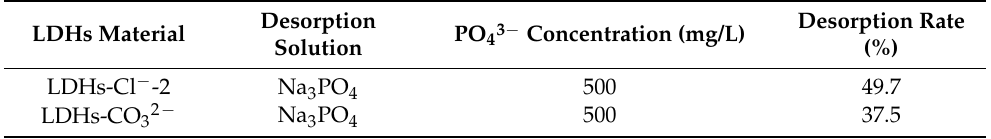
Table 7. Desorption experiment of Mg-Fe-Ti-LDHs-Cl − -2 and Mg-Fe-Ti-LDHs-CO 32 −